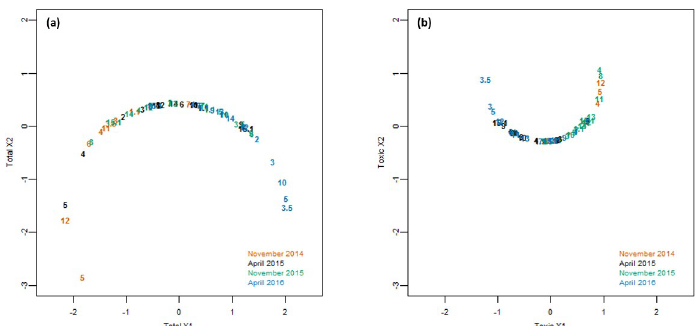
Fig 4. Nonmetric multidimensional scaling of data. Non-Euclidean Bray-Curtis distances were calculated based on the following variables: Depth (m), Distance from the Maumee River (km), Distance from the Detroit River (km),